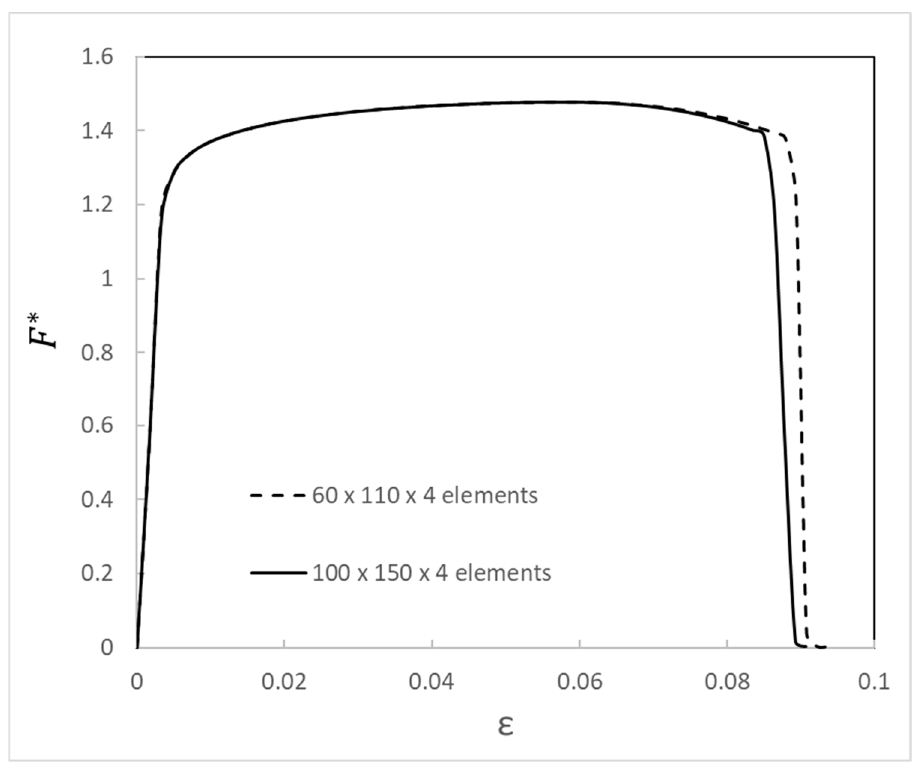
Figure 4. Effect of mesh sensitivity on force–tensile strain.